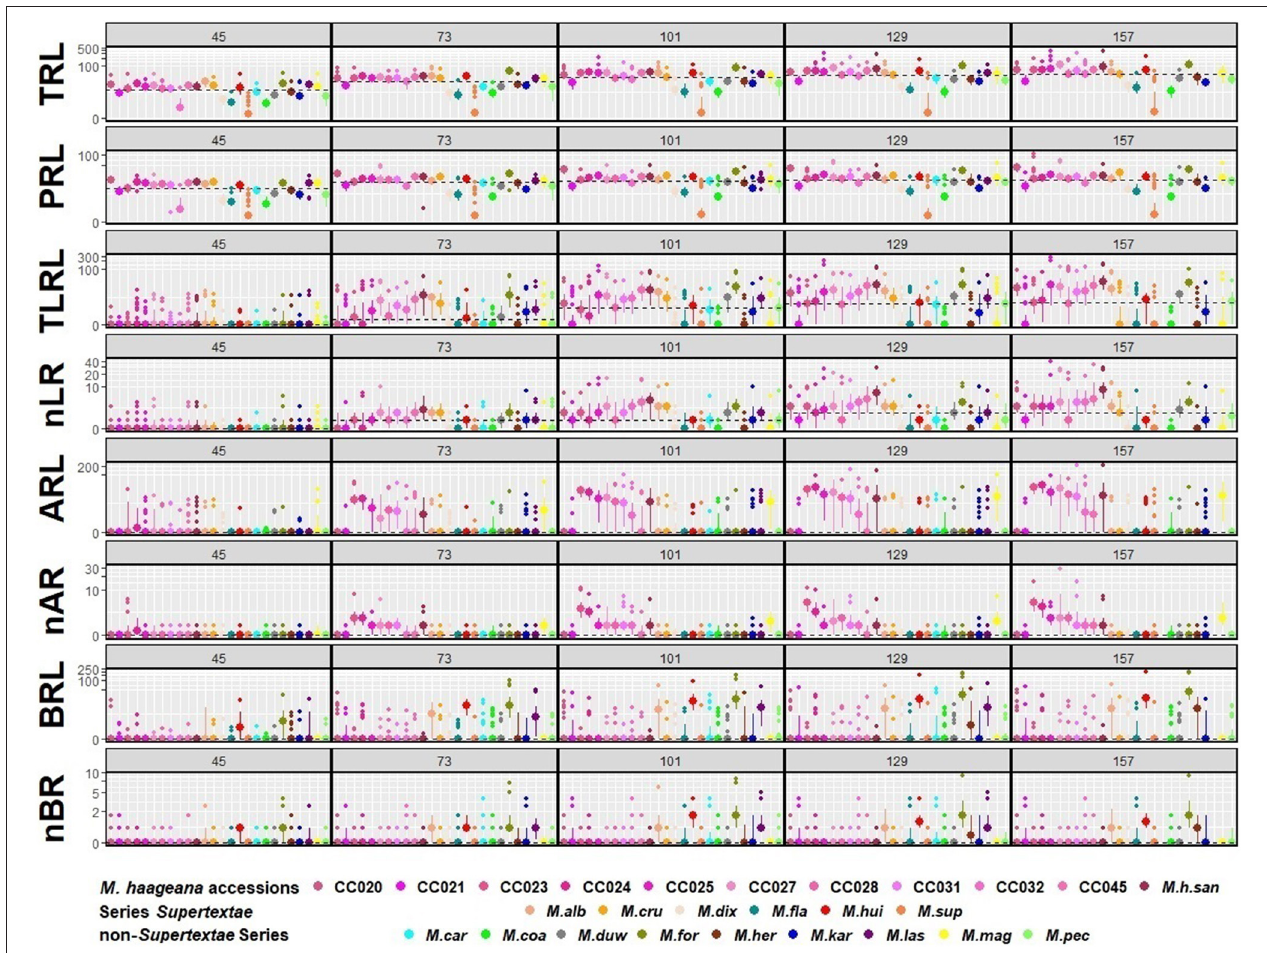
FIGURE 3 | Quantitative dynamics of root growth in M. haageana accessions, Supertextae series Mammillaria species, and non- Supertextae series Mammillaria species, at 45, 73, 101, 129, and 157 days after germination. Large dots represent the median of the accession, smaller dots represent the outliers, and bars represent the interquartile range. Horizontal dotted-lines represent the overall median for the entire developmental stage. TRL, Total Root Length; PRL, Principal Root Length; TLRL, Total Lateral Root Length; ARL, Adventitious Root Length; BRL, Basal Root Length; nLR, number of Lateral Roots; nAR, number of Adventitious Roots; nBR, number of Basal Roots. y axes are expressed in base 10 pseudo-log